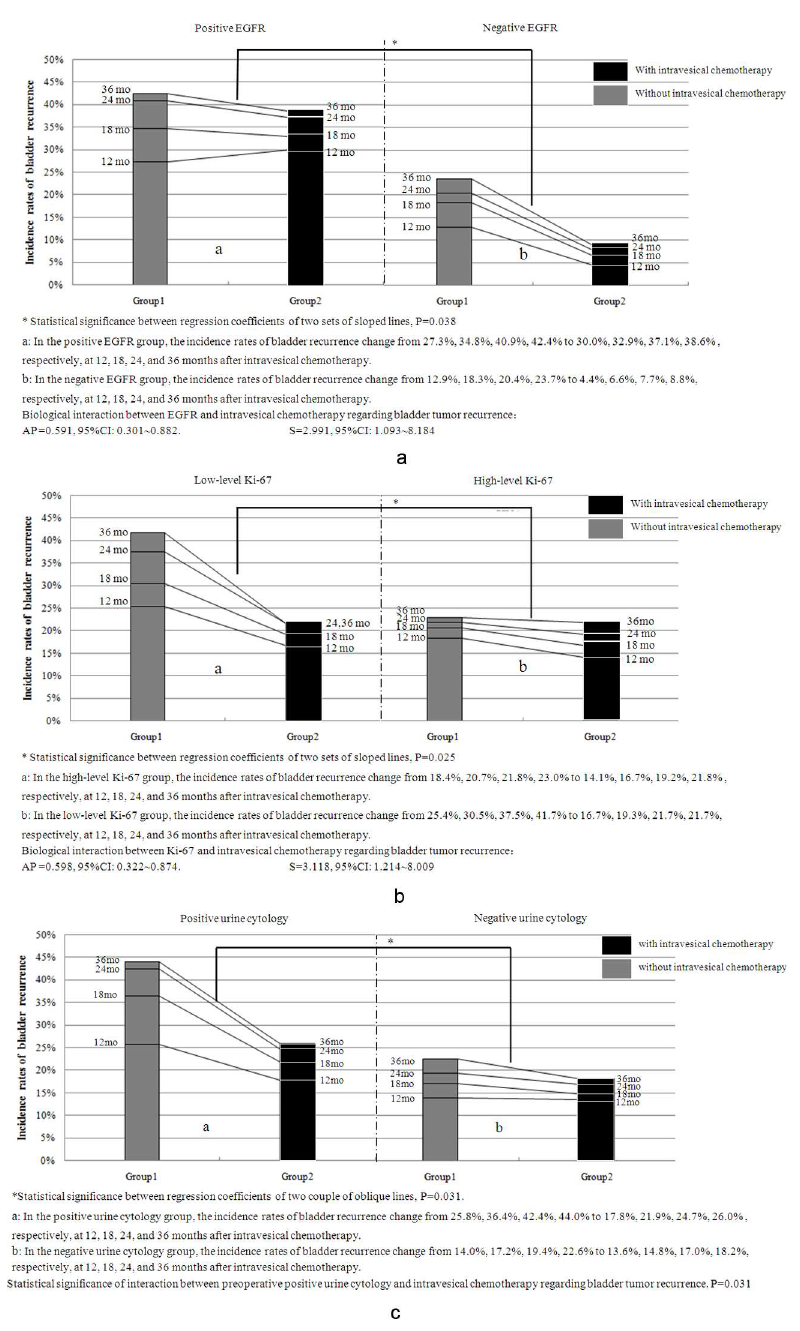
Fig 3. Differencesin the Incidence Rates of Bladder Recurrence between Patients with and without Certain Biomarkersor Conventional Clinicopathological Factors Before or After Intravesical Chemotherapy. After intravesicalchemotherapy, the incidencerates of bladdertumor recurrence decreased more in the EGFR-negative (A), low-levelKi-67 (B), and preoperative positive urine cytology (C) sub-groups than those in the corresponding sub-groupswhen comparing the regression coefficients of the two sets of obliquelines. A significantsynergistic biologicalinteraction was observedbetween intravesical chemotherapy and EGFR negativity(a, S = 2.991, AP = 0.591) or low-levelKi-67 expression(b, S = 3.118, AP = 0.598); however,no biological interactionwas observedbetweenpreoperative urine cytology and intravesical